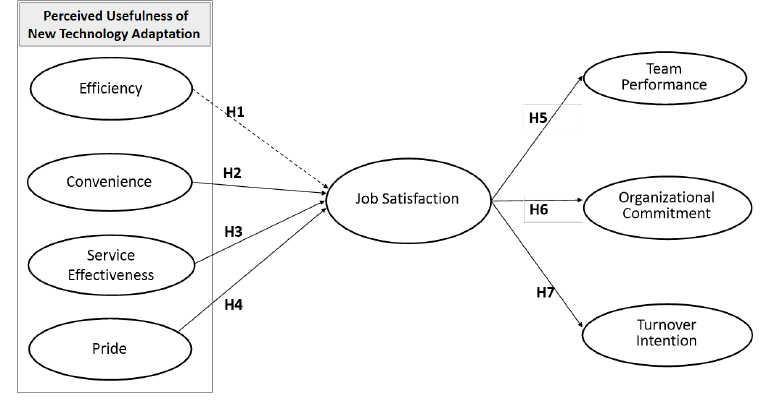
Figure 1. Research